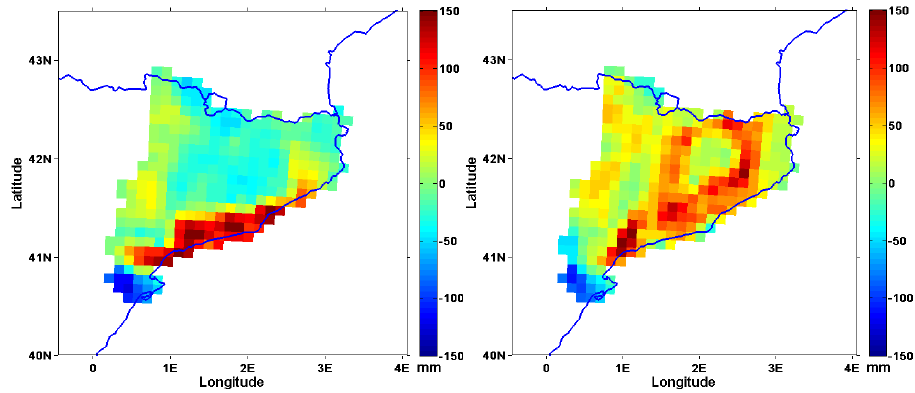
Fig. 14. Case study 1 scatterplots of MM5’s (left) and COSMO-I7’s (right) QPFs against observed rainfall, showing both models’ overesti- mations and underestimations. Figure 14. Case study 1 scatterplots of MM5‟s (left) and COSMO-I7‟s (right) QPFs 3 against observed rainfall, showing both models‟ overestimations and underestimations. 4